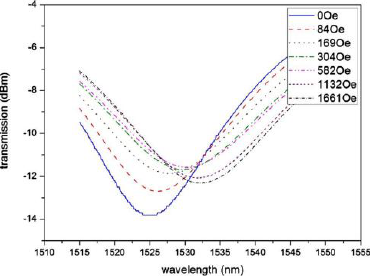
Figure 9. Transmission spectrum of the LPG-based tunable optical filter under different magnetic field intensities. Reproduced from [29], with the permission of AIP Publishing. Sensors 2017 , 17 , x FOR PEER REVIEW